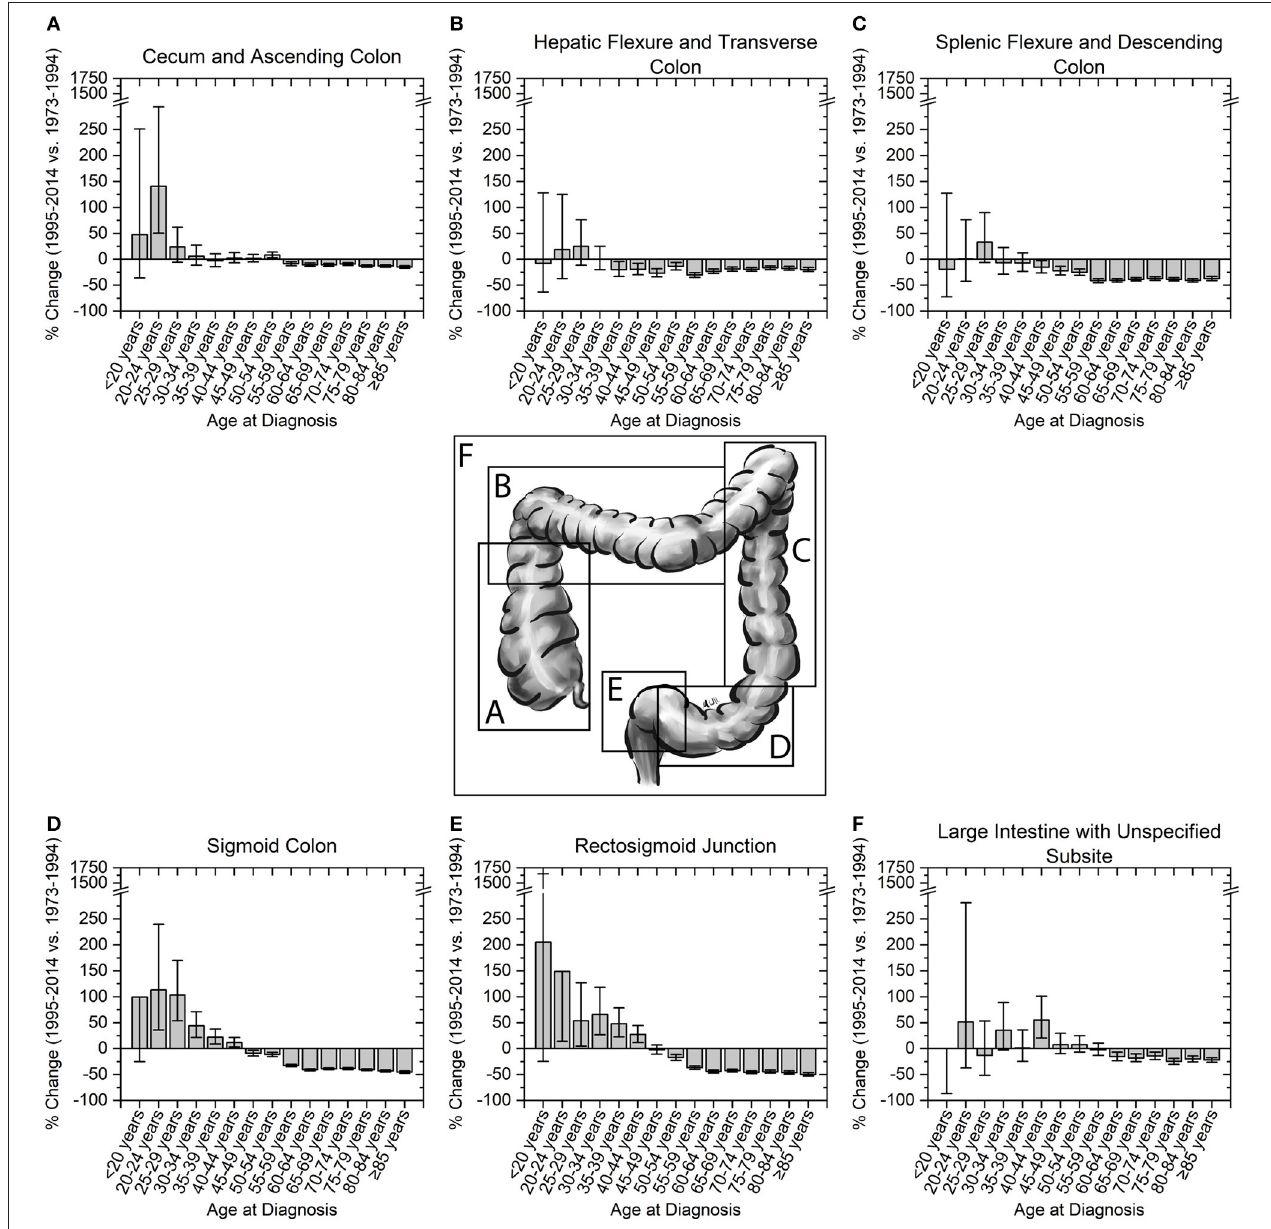
FIGURE 4 | Percent change in colon cancer incidence rate by colon subsite. Error bars represent 95% confidence intervals. (A,B) Right sided colon cancers, and (C–E) left-sided colon cancers are broken into their respective colon subsites. (F) Cancers of the large colon with unspecified subsite show a significant increase in incidence in patients aged 40–44